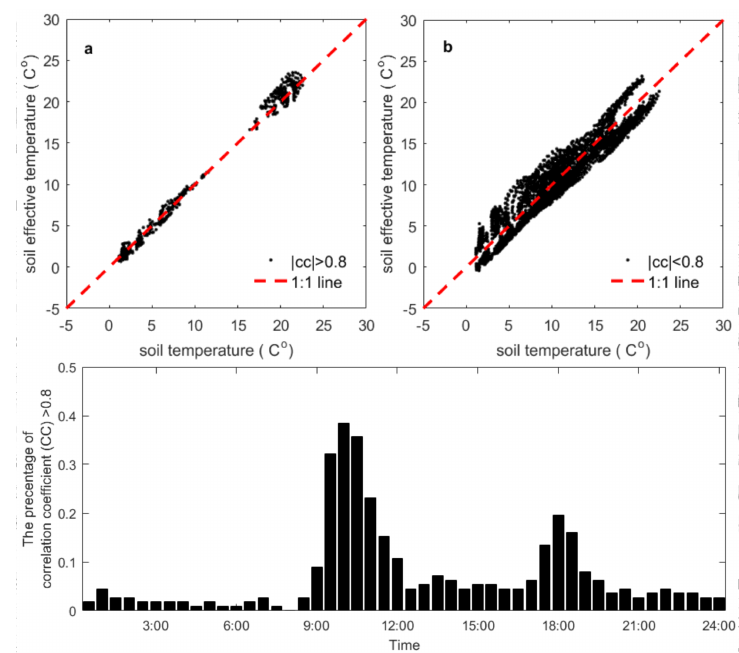
Figure 6. Comparison of soil temperature at the penetration depth vs. soil effective temperature at Maqu Center Station. The absolute correlation coefficient ( | cc | ) divided the time series into two groups where | cc | > 0.8 ( a ) and | cc | < 0.8 ( b ). The bottom figure shows the daily distribution of the moment when correlation coefficient | cc | > 0.8.